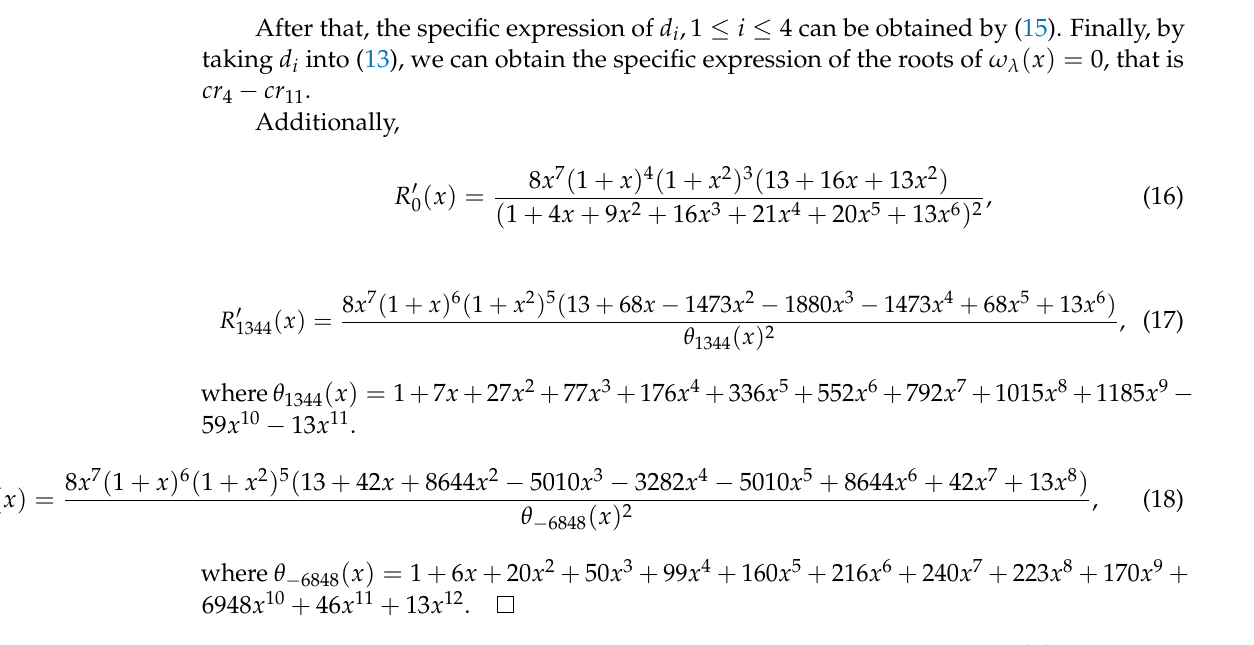
Table 2. Free critical points cr i from R (cid:48) λ cr i No. of cr